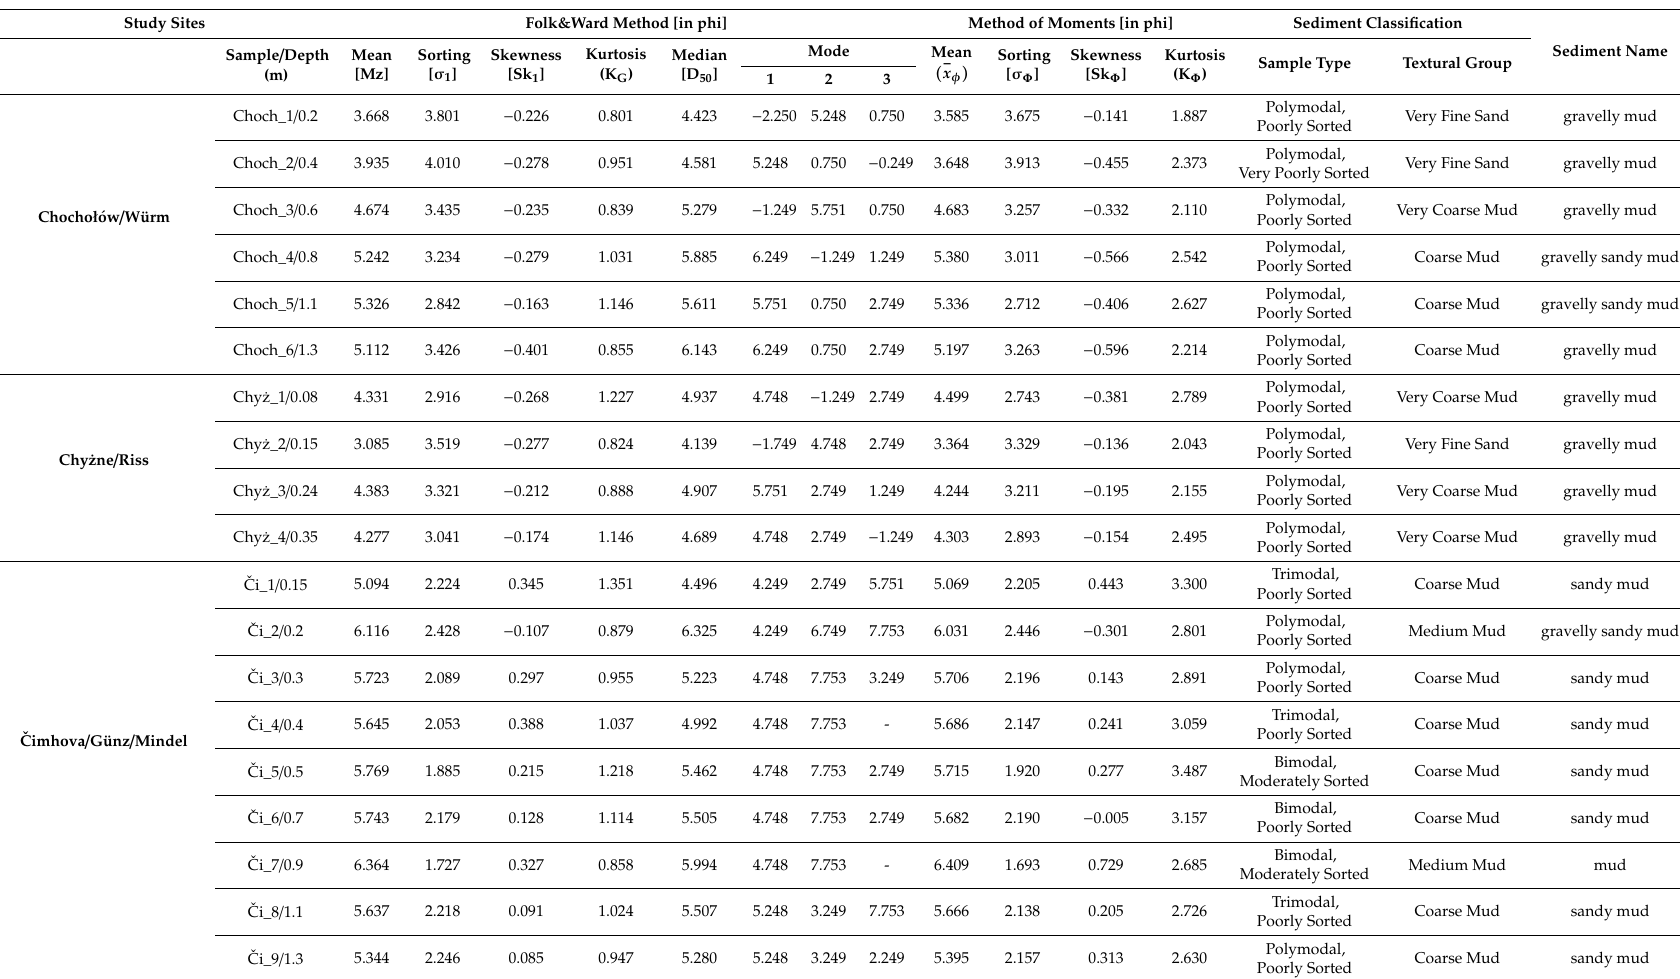
Table 1. Statistical grain-size parameters (Folk & Ward method [63] and method of moments) of loess-like deposits in the study sites. Study